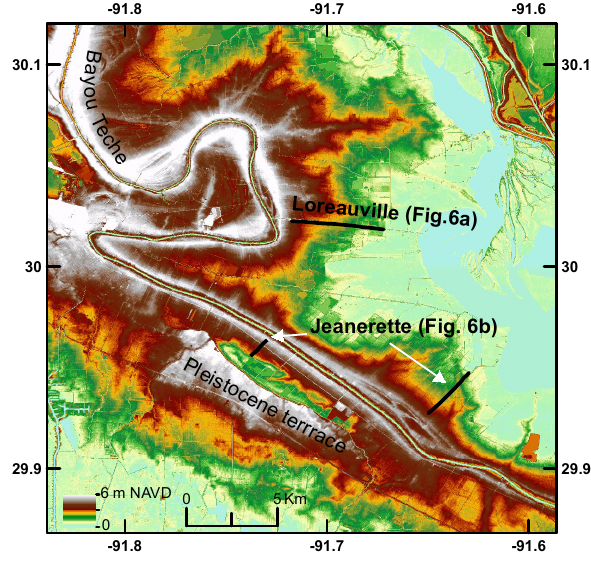
Figure 5. Digital elevation map (NED 1/3arcsec) of the Bayou Teche system near New Iberia (for location see Fig. 1b) with the location of cross sections Loreauville and Jeanerette (Fig.